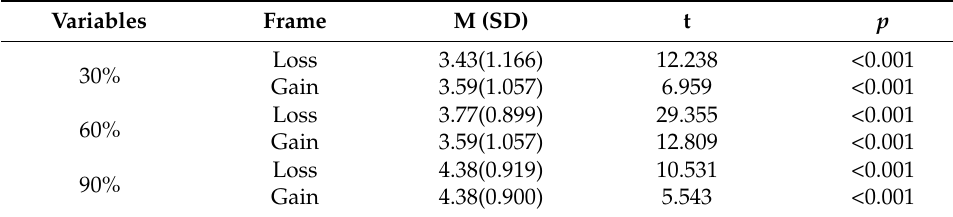
Table 4. Effect of acquaintance vaccination rate on vaccination